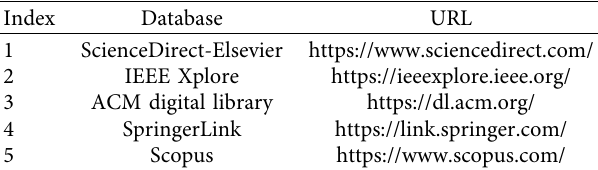
Table 1: The main electronic databases utilised in the survey.